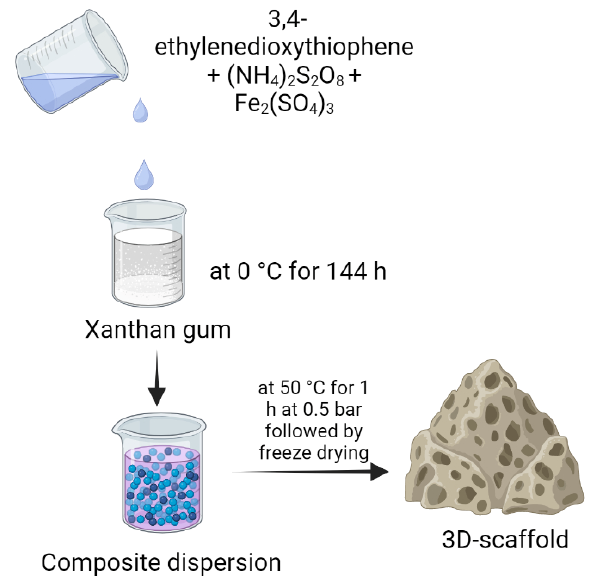
Figure 5. 3D scaffold prepared with xanthan gum and poly(3,4-ethylenedioxythiophene), as de- scribed by del Agua et al. [95].